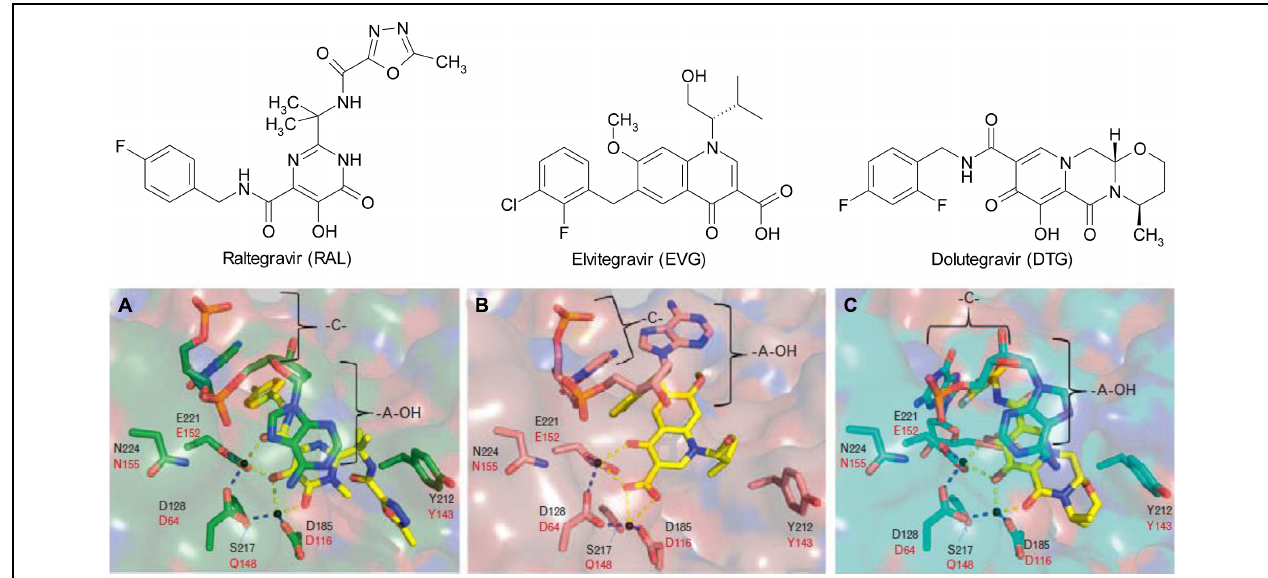
FIGURE 1 | Chemical structures of (A) raltegravir (RAL), (B) elvitegravir (EVG), and (C) dolutegravir (DTG) and their binding modes to the prototype foamy virus (PFV) integrase active site (Quashie et al., 2013b).